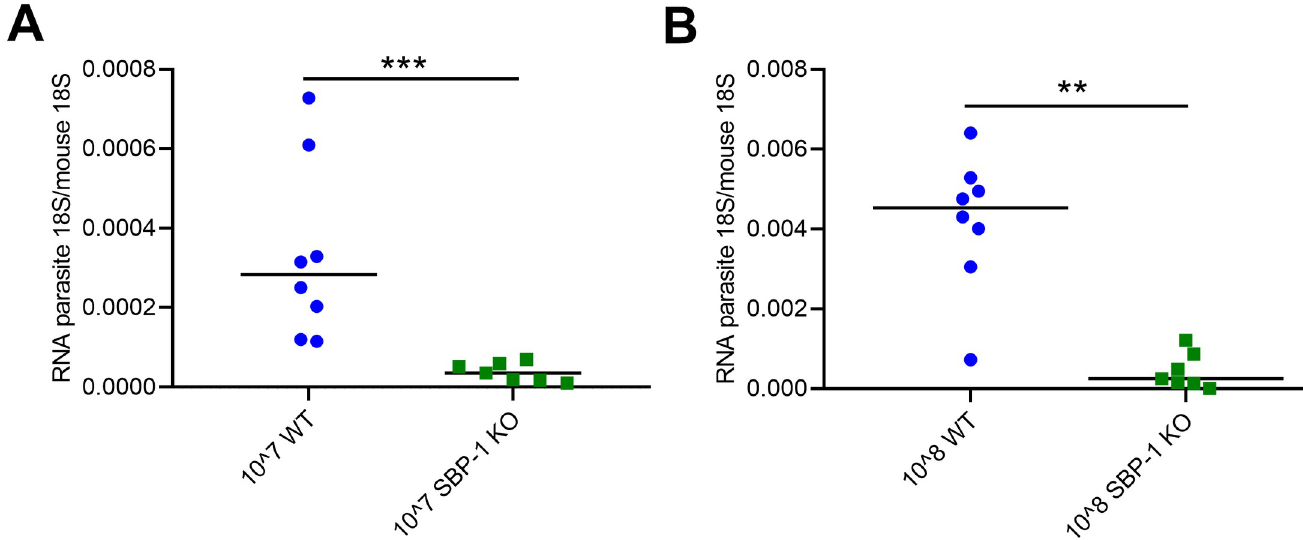
Fig 1. SBP-1 KO parasites sequester less than WT Pb NK65. Mice were i.v. injected with 10 7 or 10 8 SBP-1 KO or WT schizonts. After 22 h, mice were euthanized, perfused and dissected. (A-B) Lungs of the mice were homogenized and mRNA levels of parasite 18S and mouse 18S were measured with qRT-PCR. Horizontal lines with asterisks on top indicate significant differences between groups. Data of two experiments, n = 7–8 per group.